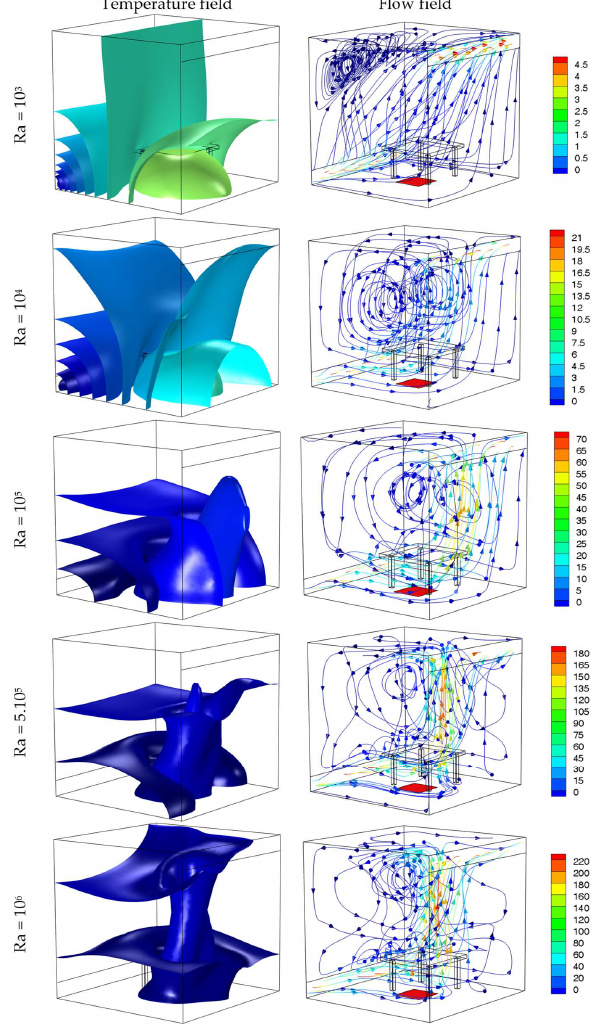
Figure 9. Effect of Rayleigh number variation on the distribution of temperature iso-surfaces and particle trajectories for a heat source position as indicated in case 5.